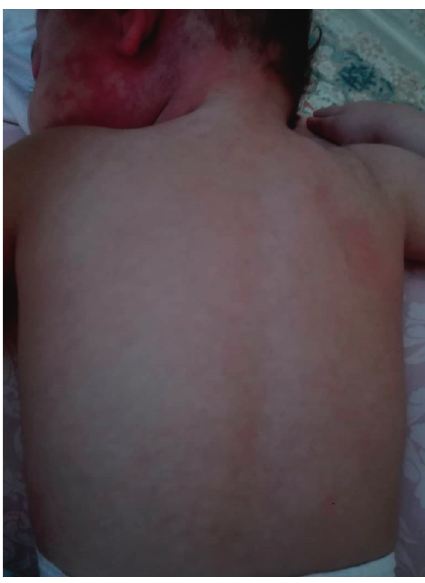
Figure 6: Spontaneous resolution of cutaneous lesions of